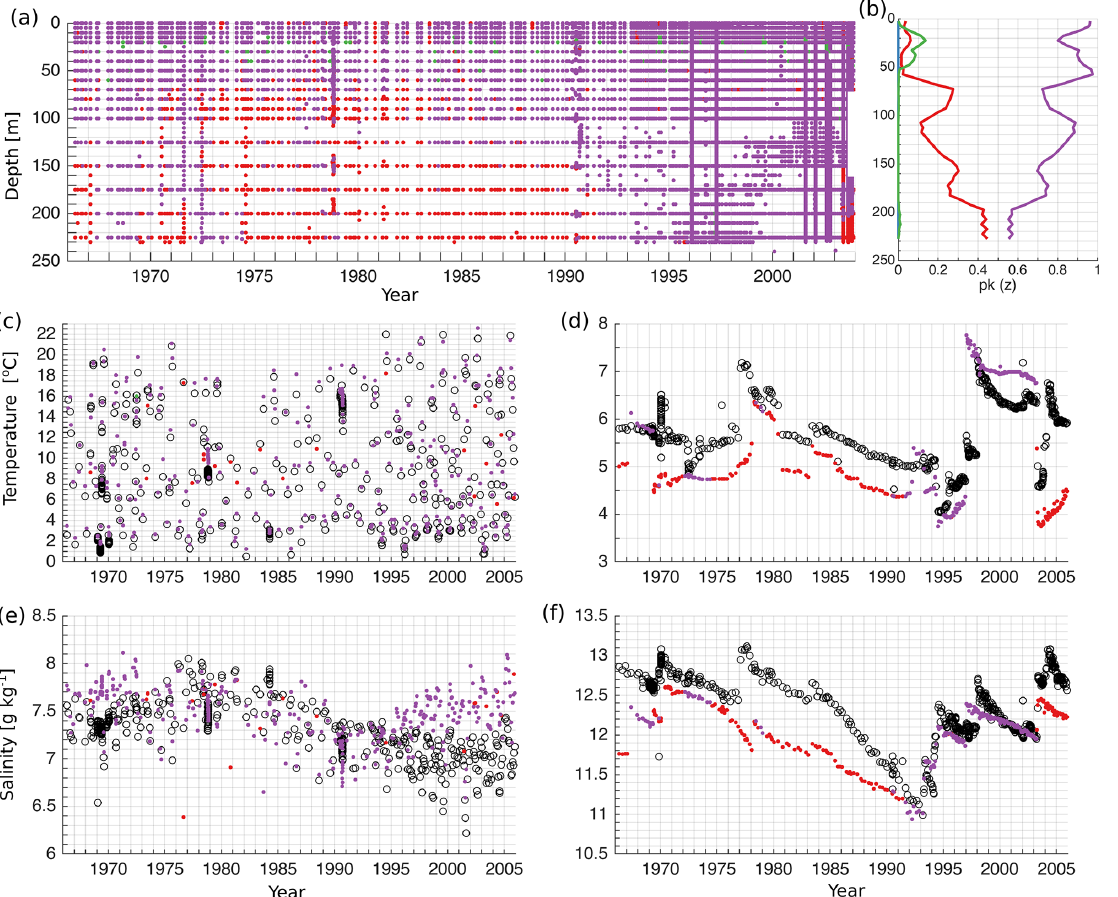
Figure 6. Hovmöller diagram of the distribution of error points of K = 4 at the BY15 monitoring station (a) . Vertical distribution of the share of error points belonging to the four different clusters (b) . The share, p(k) , representing the share of the error points belonging to the cluster k , is calculated as explained in Sect. 2.4. Time series of observed (black circles) and simulated (colour dots) temperature (c, d) and salinity (e, f) on the surface (c, e) and bottom (d, f) at the BY15. Colours of dots and lines correspond to the colours of the clusters in Fig.